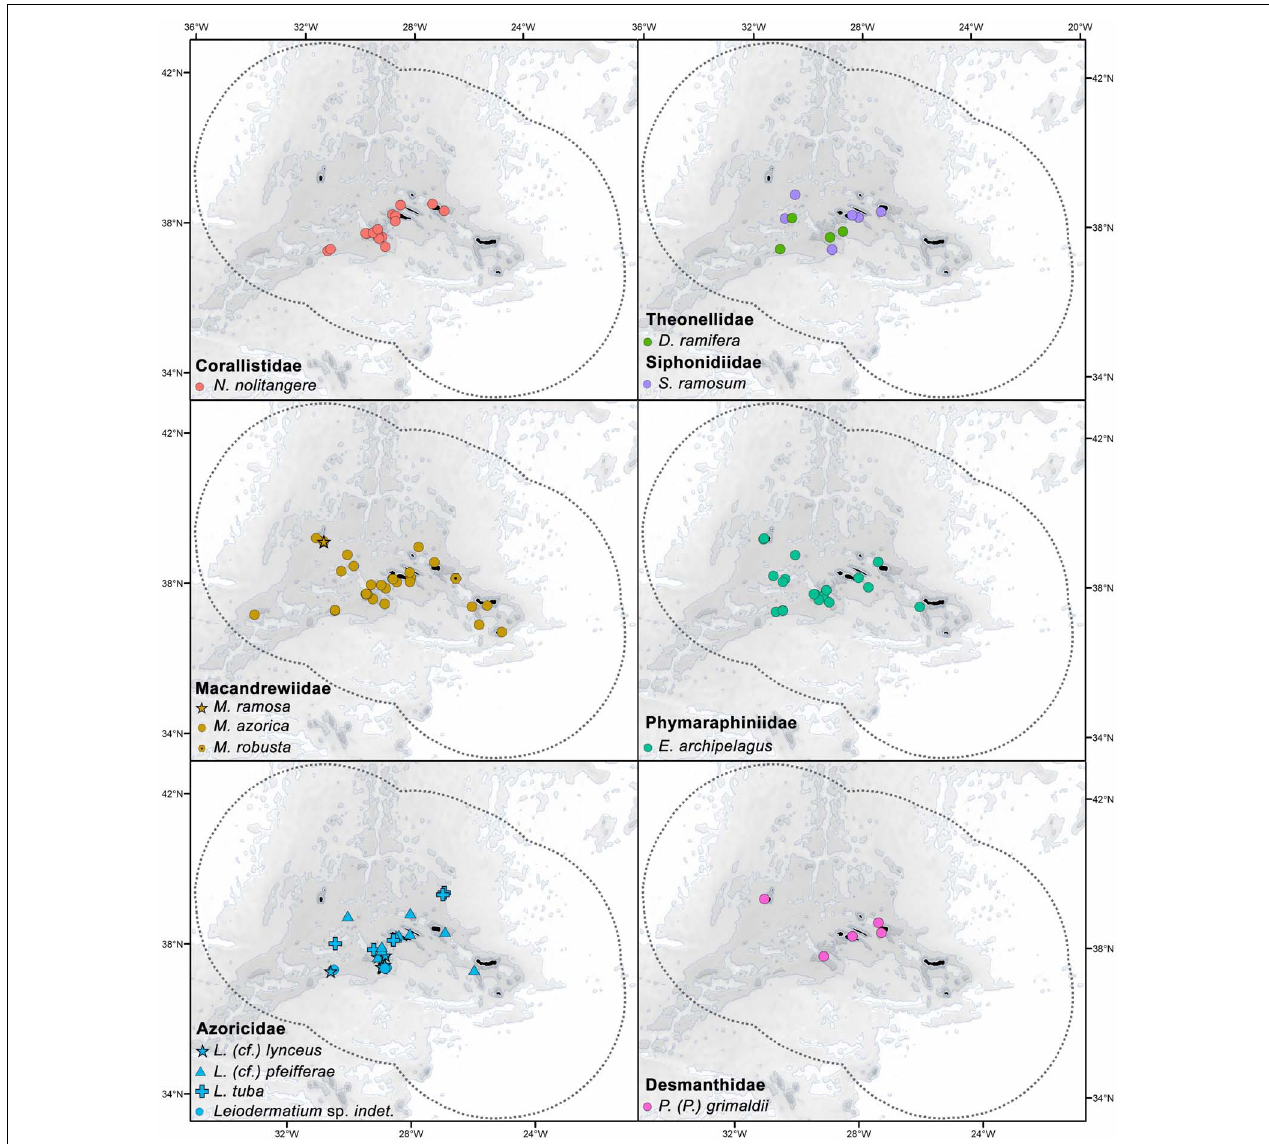
FIGURE 3 | Distribution of lithistid species within the Azores EEZ based on literature records and analyzed